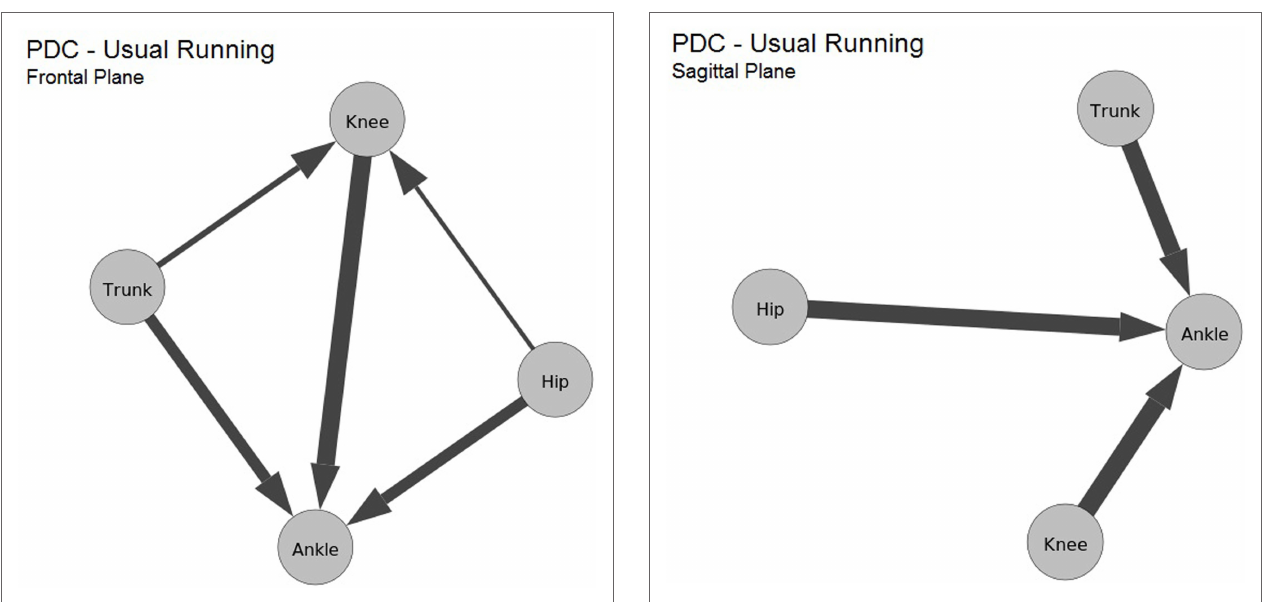
FIGURE 5 | Average values computed from maximum PDC values of the sagittal plane kinematic data during running. As in Figure 4 , the nodes are the kinematic data.